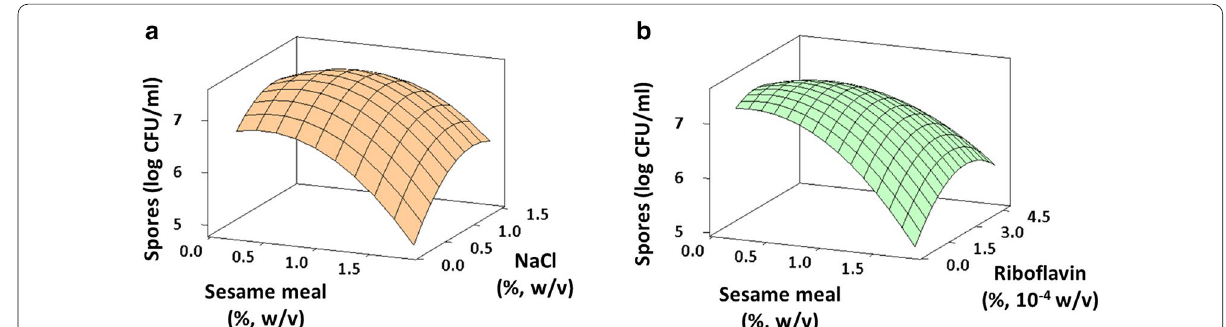
Fig. 2 Interactions between growth factors visualized as a three-dimensional response surface plot. Interaction between a sesame meal and NaCl, b sesame meal and riboflavin. Interaction between NaCl and riboflavin was not plotted due to the lack of statistical significance